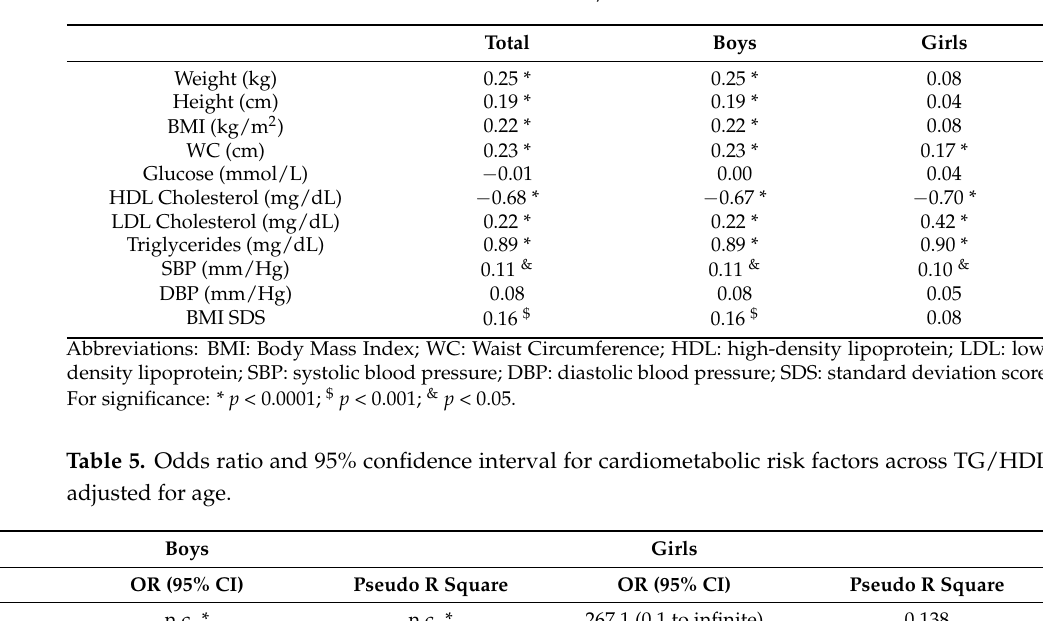
Table 4. Bivariate correlation coefficients between TG/HDL and metabolic characteristics.